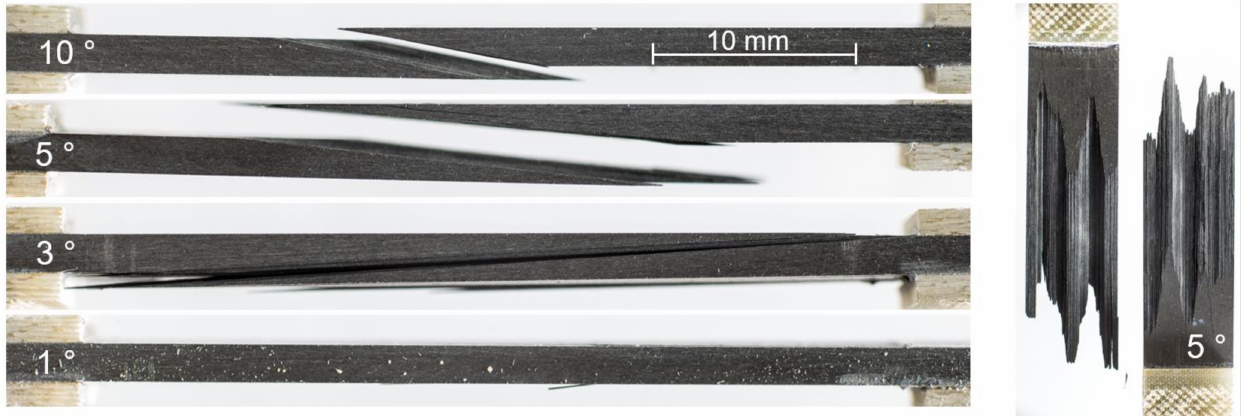
Figure 4. Thermally not treated samples with out-of-plane fibre orientation after tensile